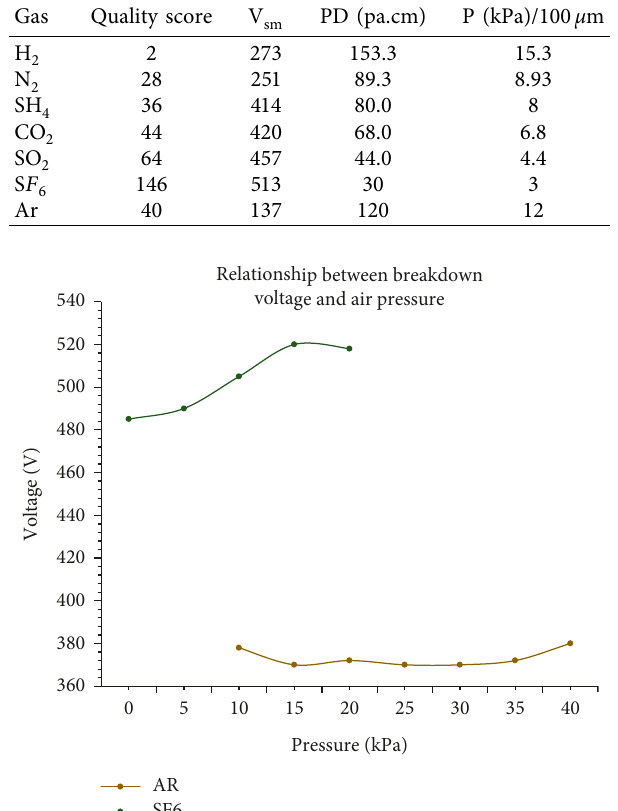
Figure 8: Ar and SF6 breakdown voltage versus gas pressure.